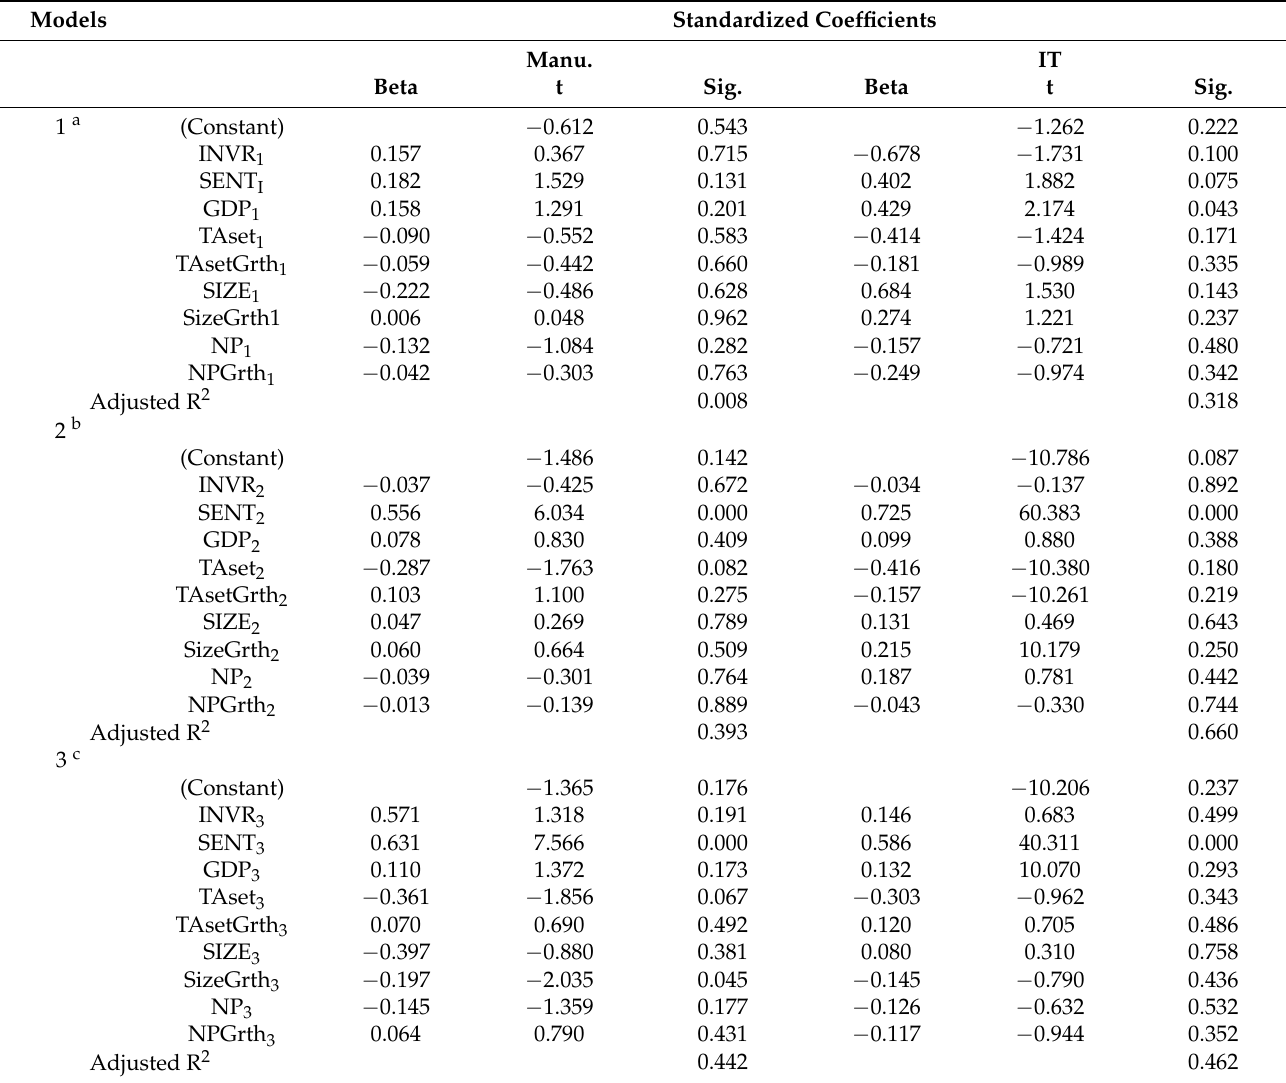
Table 7. Investment contributions to market value of manufacturing and IT firms in the three years after IPO.